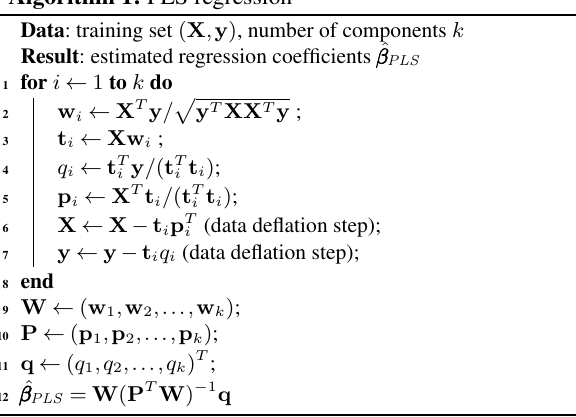
Algorithm 1: PLS regression